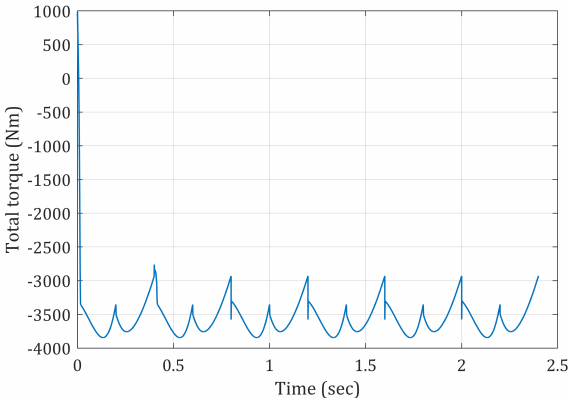
Figure 20. Total torque waveform of the ORDSPMG under study.